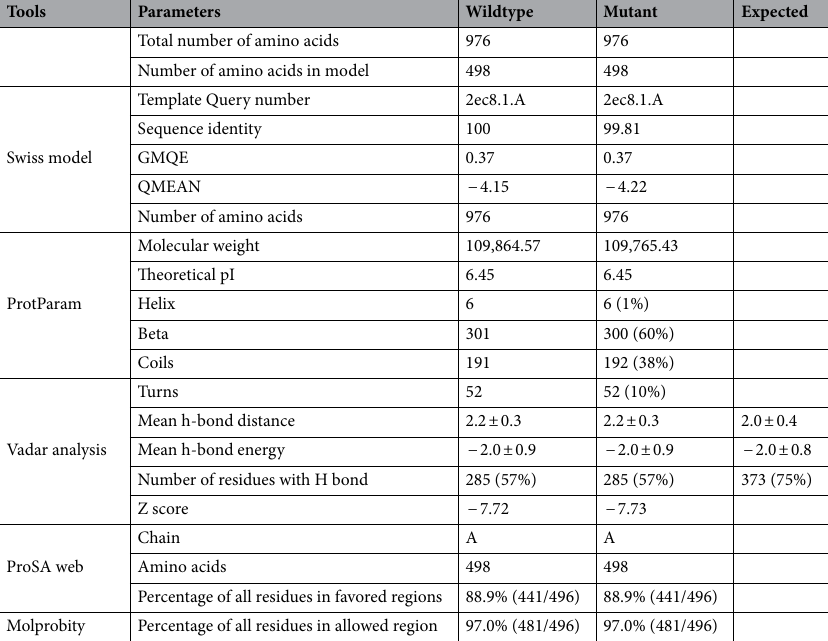
Table 3. In silico analysis of mutant and wildtype c-kit gene of Acute Myeloid Leukemia patients (n = 31).